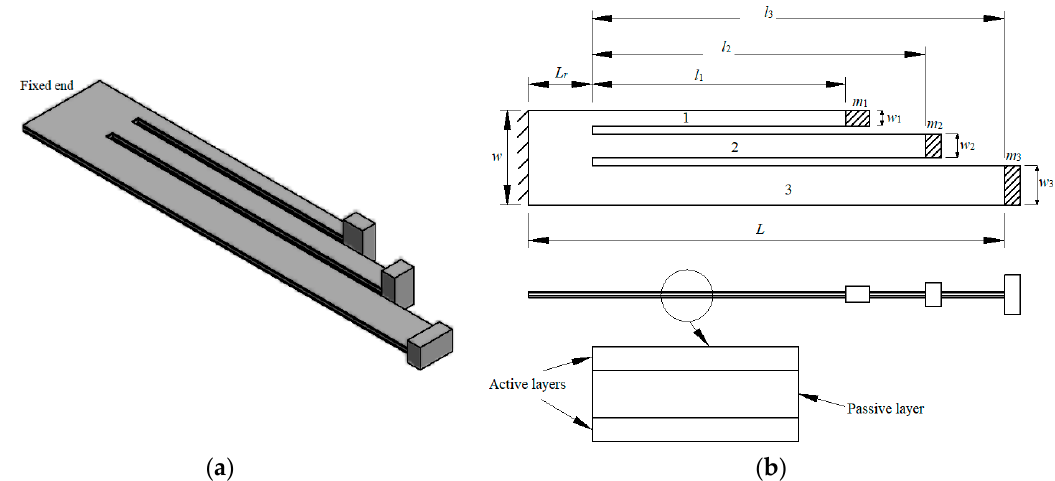
Figure 1. Configuration of the proposed harvester: ( a ) 3D view and ( b ) detailed view.